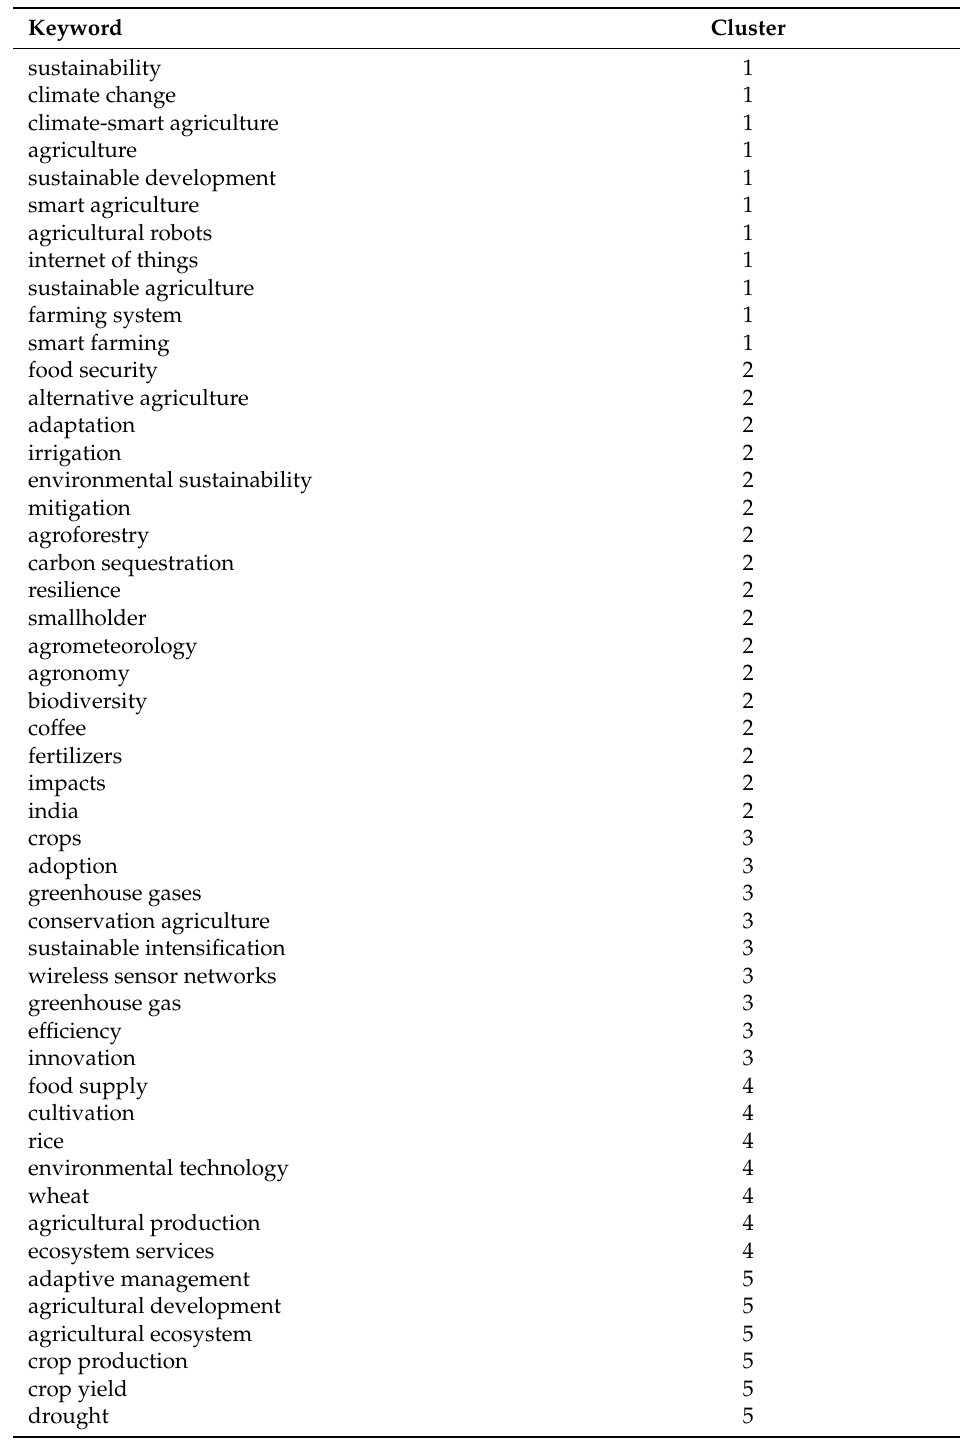
Table 2. Results for the factor-cluster analysis with the information from top 50 keywords (occurrences and average publication